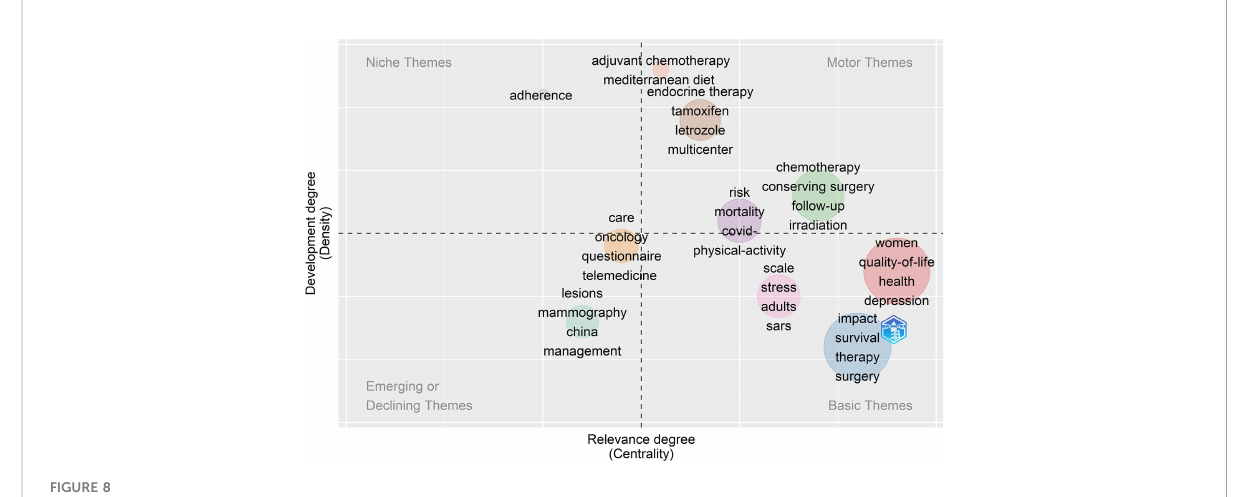
FIGURE 8 The thematic map of keywords